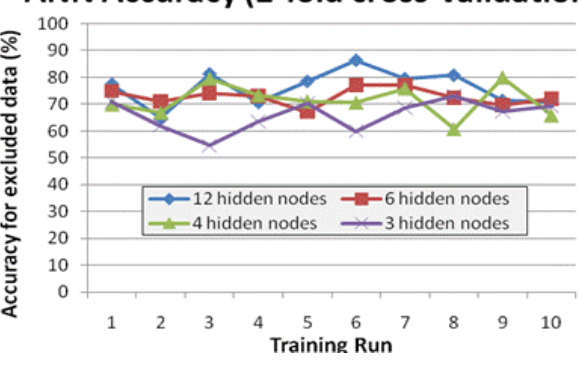
Fig. 3: ANN Accuracy for Unknown Environments Fig. 3 and Fig. 4 present accuracy results for ANNs and SVMs respectively for operating environments un- known until runtime. The ANNs are randomly assigned initial weights for the connections between nodes which accounts for variations in accuracy across training